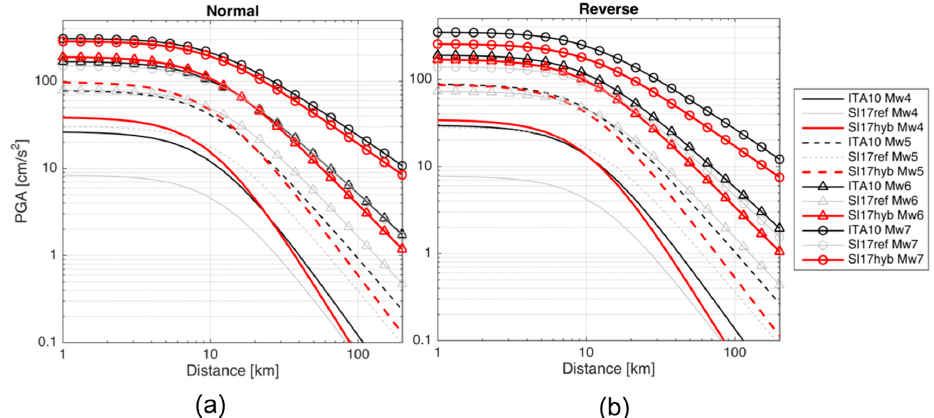
Figure 24. GMPEs used in the logic tree plotted according to the different moment magnitudes (from 4 to 7) and for normal ( a ) and reverse ( b ) faults. Black lines, ITA10 [40]; gray lines, SI1ref; red lines, SI17hyb. SI17ref in panel ( b ) is for the undefined style of faulting. Table 7. Seismic characterization of each SHARE zone [70]. a and b are the parameters of the Gutenberg–Richter distribution. M min and M max are the minimum and maximum moment magnitudes for PSHA. FM: Focal Mechanism; NF: Normal Faulting; RF: Reverse Faulting. h: Reference depth. ASC: Active Shallow Crust; SSC: Stable Shallow Crust.